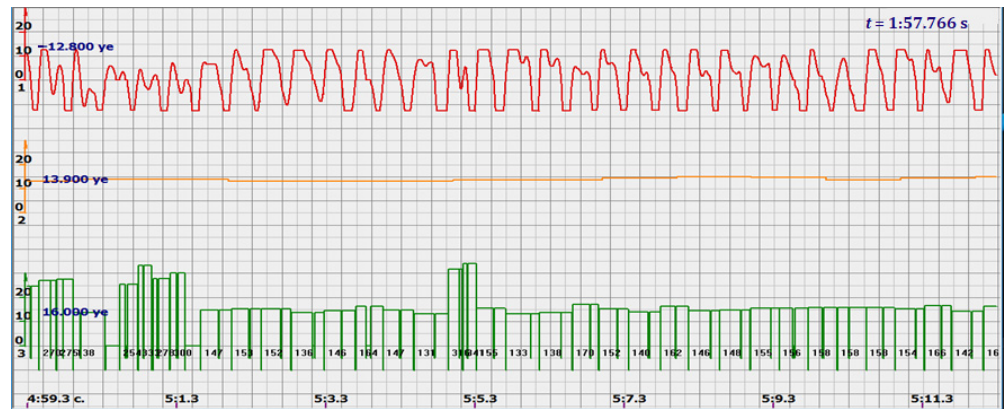
Figure 11. diagram during fetal movement—signal distortion and measured intervals.